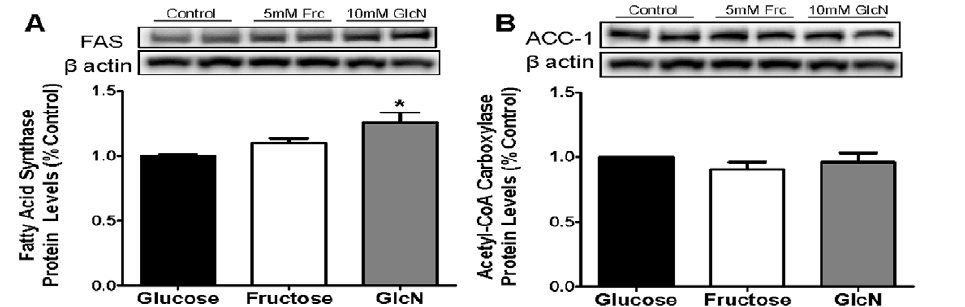
Figure 2. Elevation of FAS but not ACC-1 protein levels by GlcN treatment in HepG2 cells. Protein levels of key lipogenic enzymes ( A ) FAS and ( B ) ACC-1 in HepG2 cells incubated for 48 hours in media containing 5.5 mM glucose, glucose + 5 mM fructose, or glucose + 10 mM GlcN. Significant increase in FAS protein levels of HepG2 cells exposed to 10 mM GlcN relative to control was seen. There was no statistical difference between the protein levels of ACC-1 in any of the treatment groups. *P , 0.05 vs. controls. Means 6 SEM are depicted; n=6 for each group.